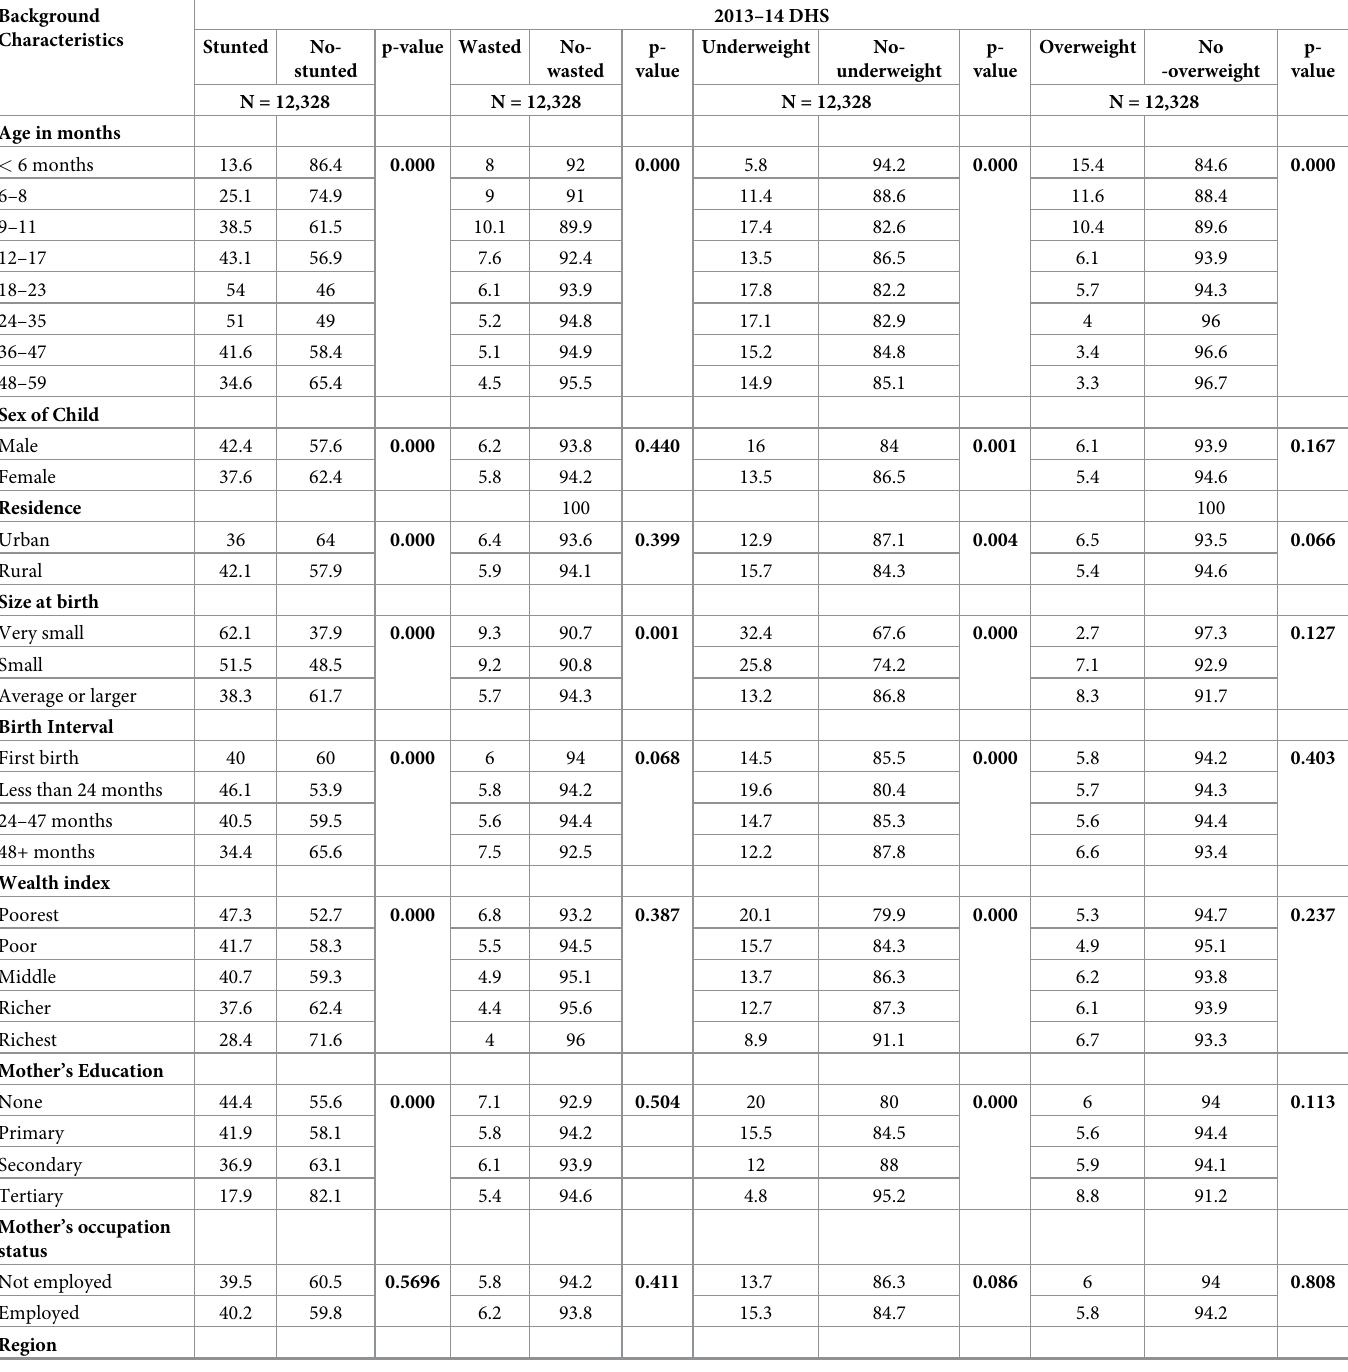
Table 1. Bivariate analysis of childhood malnutrition indicators with background characteristics (2013/14 DHS data). Background